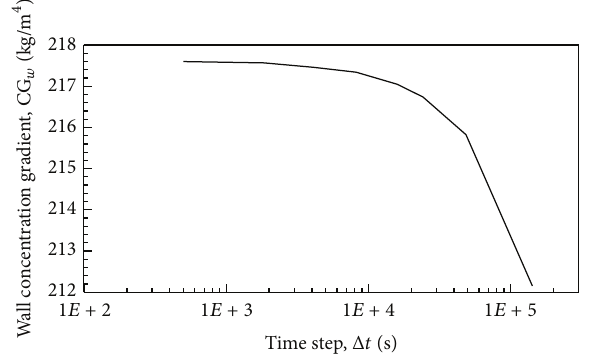
Figure 2: Effect of the spatial grid step size, Δ𝑥 and Δ𝑦 , on the gradient of the chloride concentration at the left boundary, 𝑥 = 0 , for 𝑦 = 0 , 𝑡 = 1 year, and a time step Δ𝑡 = 8000 s.